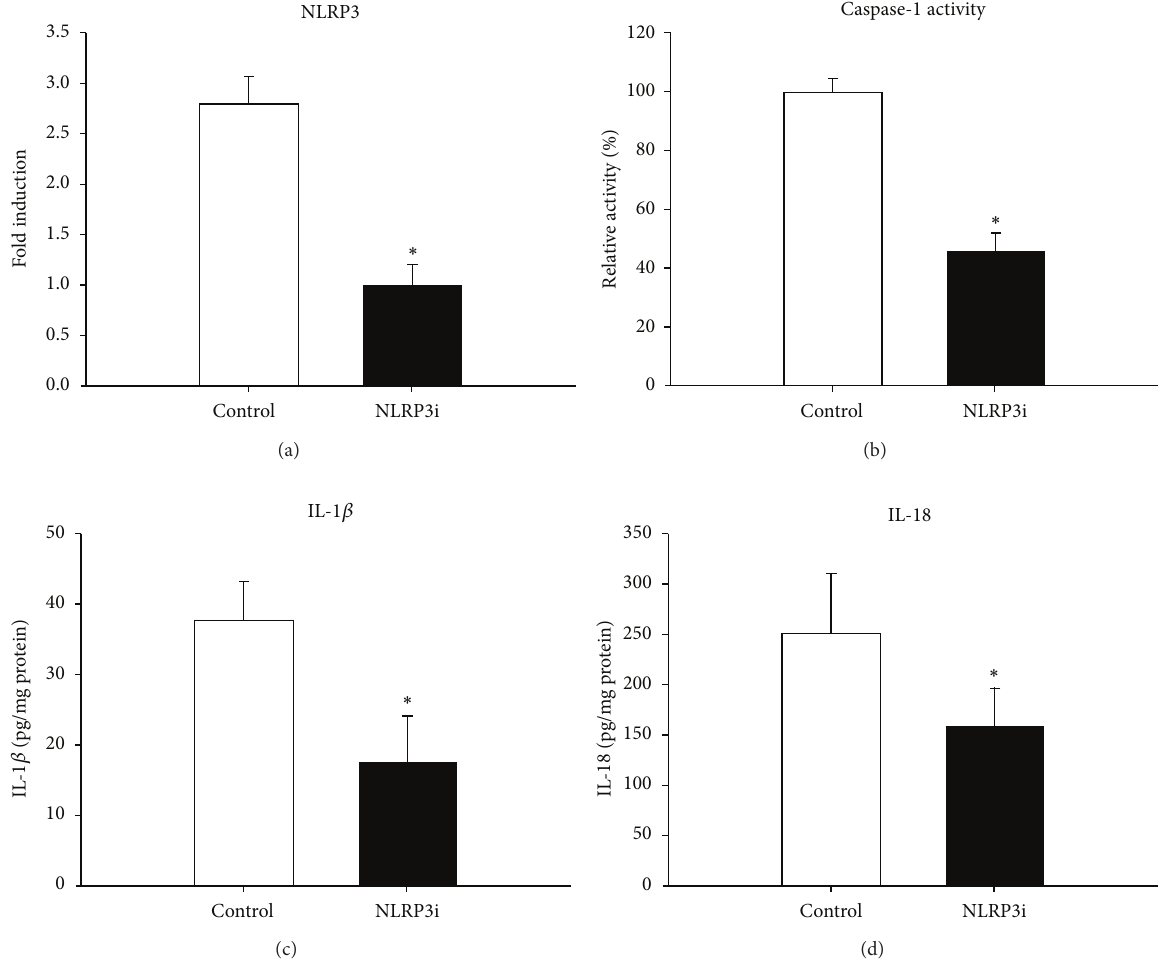
Figure 1: Efficiency of lentivirus transfection. (a) NLRP3 interference downregulated NLRP3 mRNA expression by 64.3% compared with the control via real-time PCR analyses. (b) Caspase-1 activity in protein extracted from aortas was reduced by 56% after NLRP3 silencing, compared with the control. (c and d) Silence of NLRP3 decreased the downstream proinflammatory factors, IL-1 𝛽 and IL-18, using ELISA. ∗ 𝑃 < 0.05 versus control. Values are mean ±